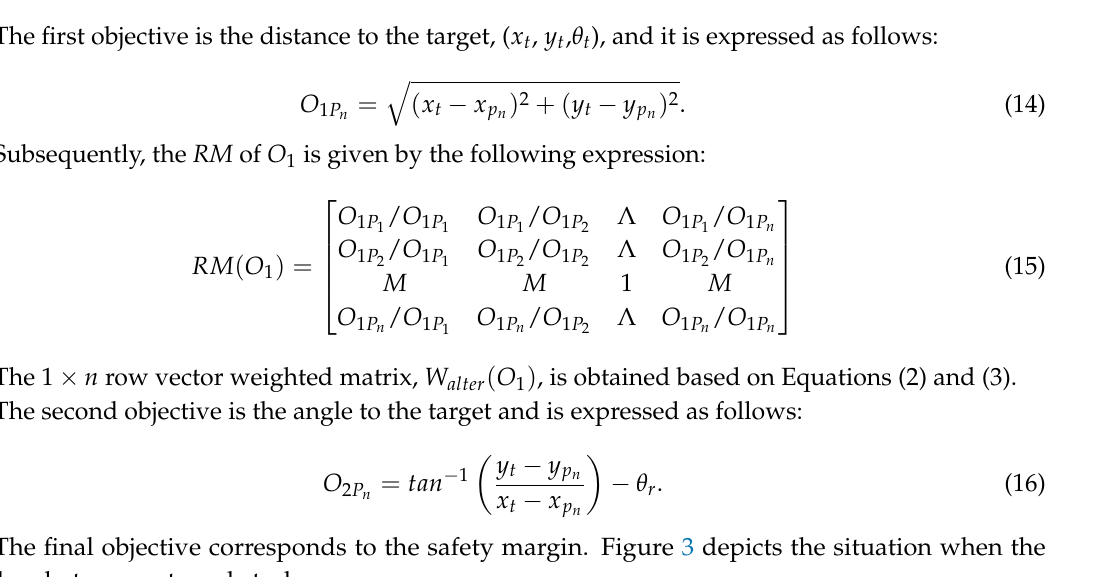
Figure 2. Coordinate system of a mobile robot with a laser range finder (LRF)